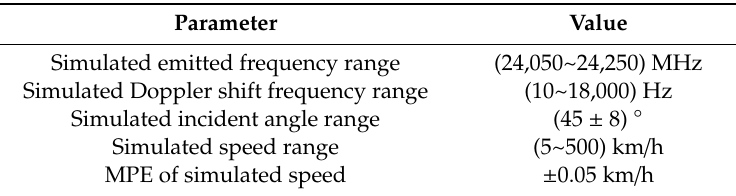
Table 1. Main parameters of the simulation